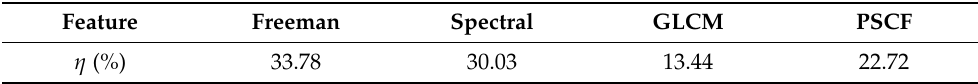
Figure 6. Feature importance ring graph. Table 4. Feature importance of four characteristic